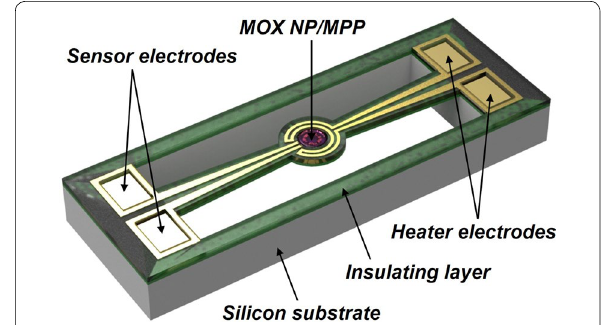
Fig. 1 Schematic of a single sensor. The sensing part is suspended to prevent conduction of heat to the substrate and its subsequent loss